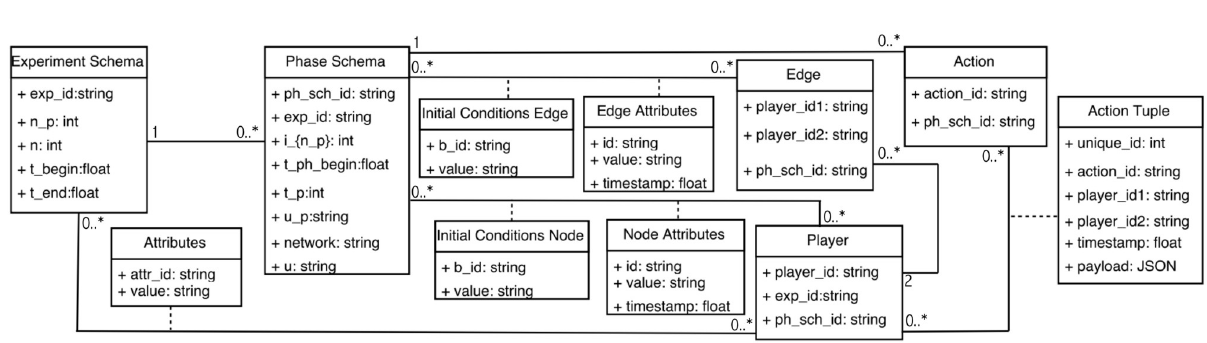
Fig 7. Data model of Table 3 translated into a entity-relationship diagram in unified modeling language (UML) form. This illustrates that the abstract data model can be translated to customary forms of data models (e.g., UML) that are more amenable for software development.